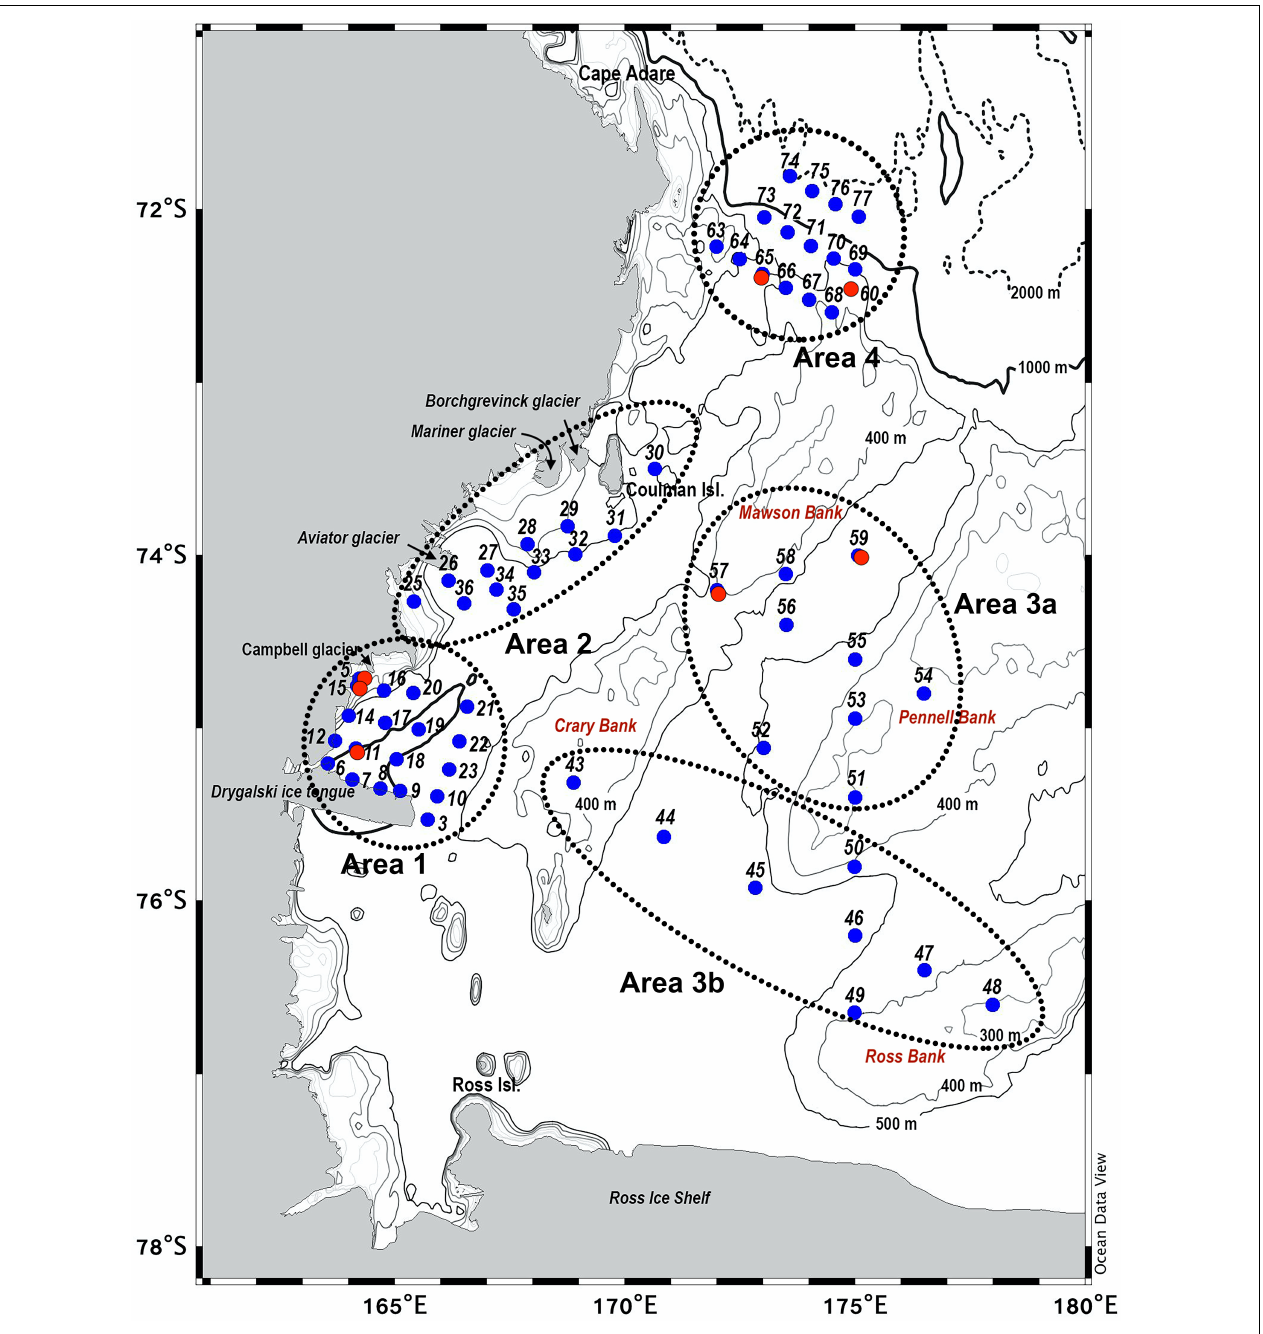
FIGURE 1 | Stations sampled in P-ROSE and CELEBeR projects. Dotted lines indicate: Area 1, St. 3–23; Area 2, St. 25–36; Area 3a, St. 43–50; Area 3b, St. 51–59; Area 4, St. 63–77. Red points indicate repeated stations.